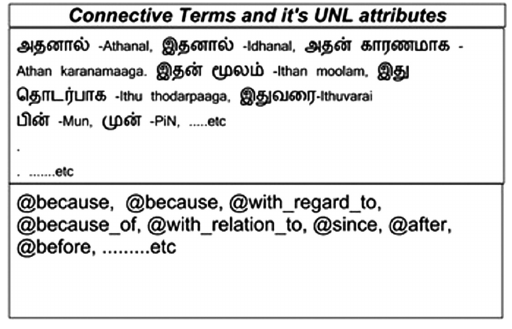
Figure 4. Connective Terms and Its UNL